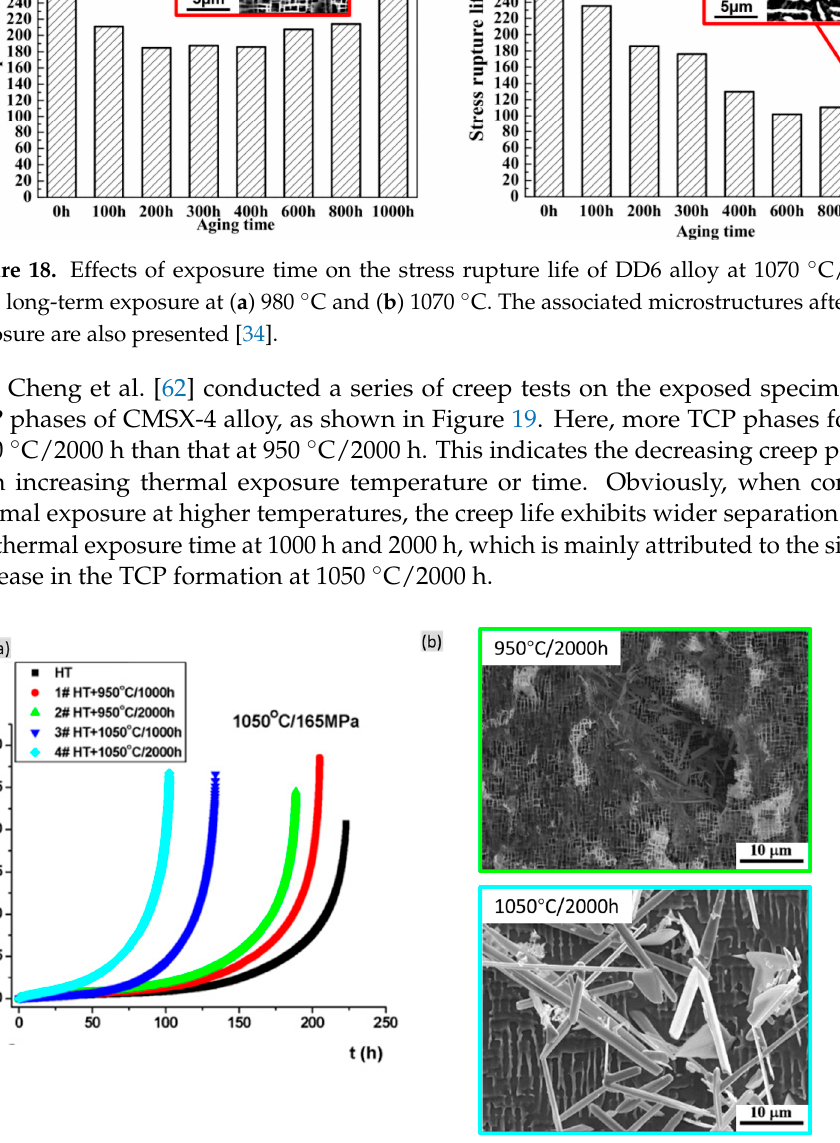
Figure 19. ( a ) Creep properties of specimens at HT state and after thermal exposure at different temperature and time of CMSX-4 alloy and ( b ) the associated microstructures after thermal expo- sure of 950 °C/1000 h and 1050 °C/1000 h